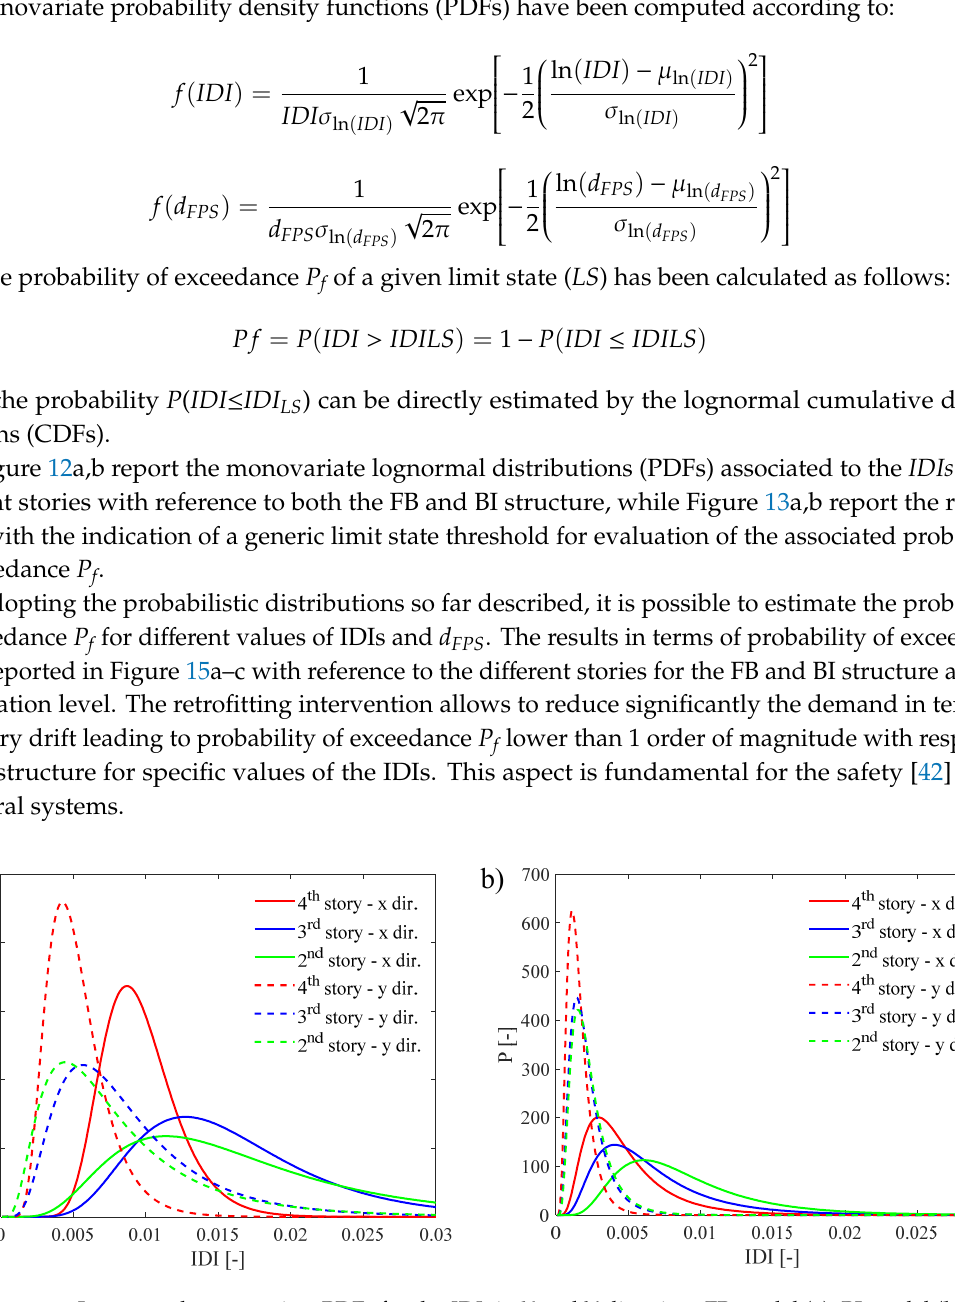
Figure 13. Lognormal monovariate CDFs for the IDIs in X and Y direction: FB model ( a ), BI model ( b ). Concerning the BI structure, Figure 14a,b illustrate the monovariate lognormal distributions (PDFs) and the cumulative density functions (CDFs) related to the d FPS in both the X and Y directions. It can be recognized that the retrofitting intervention is able to reduce the probability of exceedance of pre ‐ determined limit state threshold. Because the structure turns out to be stiffer in the Y direction, both IDIs and d FPS in that direction are significantly smaller if compared to the values in the X direction. Adopting the probabilistic distributions so far described, it is possible to estimate the probability of exceedance P f for different values of IDIs and d FPS . The results in terms of probability of exceedance P f are reported in Figure 15a–c with reference to the different stories for the FB and BI structure and for the isolation level. The retrofitting intervention allows to reduce significantly the demand in terms of interstory drift leading to probability of exceedance P f lower than 1 order of magnitude with respect to the FB structure for specific values of the IDIs. This aspect is fundamental for the safety [42] of the structural systems. The descending trend of the exceeding probabilities plotted in Figure 15 is perfectly in line with the results described in [3,17]. In fact, higher values of the limit state thresholds are associated to lower and lower values of P f in relation to both superstructure and isolation level. The analysis puts in evidence the importance to assess the seismic performance in probabilistic terms for each story and along the both directions for the both models (i.e., FB structure and BI structure). In fact, the results highlight the structural weakness along the X direction and higher values of the exceeding